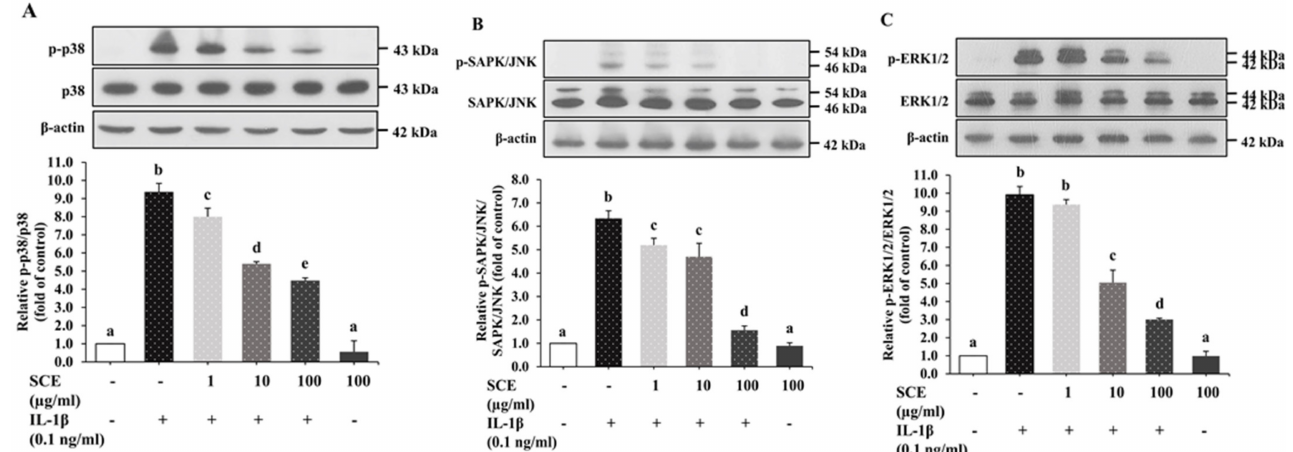
Figure 6. Effect of SCE on IL-1 β -induced MAPK pathways in ARPE-19 cells. ARPE-19 cells were treated with 1–100 µ g/mL SCE for 1 h before adding IL-1 β for 24 h. Protein expressions of phospho- rylated and total ( A ) p38, ( B ) SAPK/JNK, and ( C ) ERK1/2 were determined using immunoblotting of cell lysates. Band densitometry values of p-p38, p-SAPK/JNK, and p-ERK1/2 were normalized to the total form of p38, SAPK/JNK, and ERK1/2, respectively. Data are presented as mean ± SD ( n = 3). The different superscripts (a–e) indicate significant differences among groups at p < 0.05. 2.7. Effect of SCE on the NF- κ B Signaling Pathway in ARPE-19 Cells Induced with IL-1 β